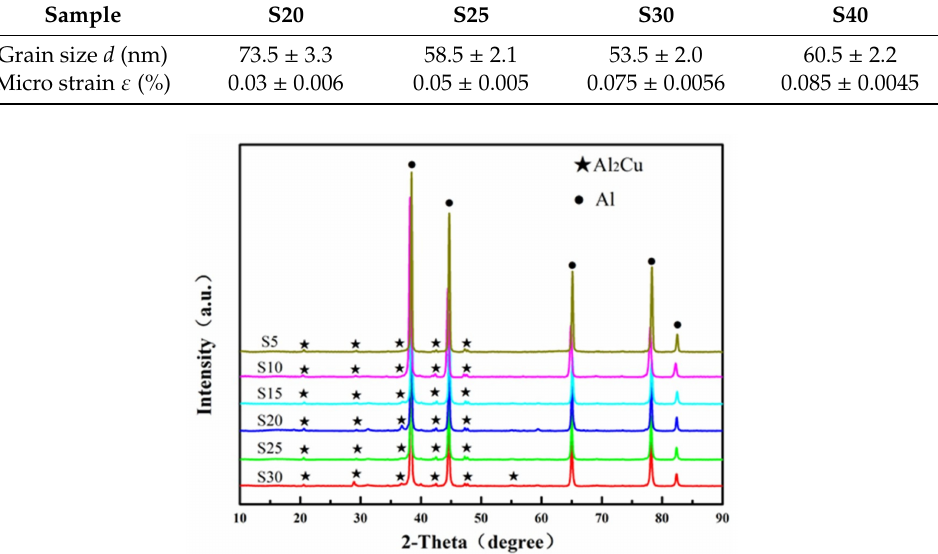
Figure 6. XRD patterns of sintered samples with di ff erent ball milling time.